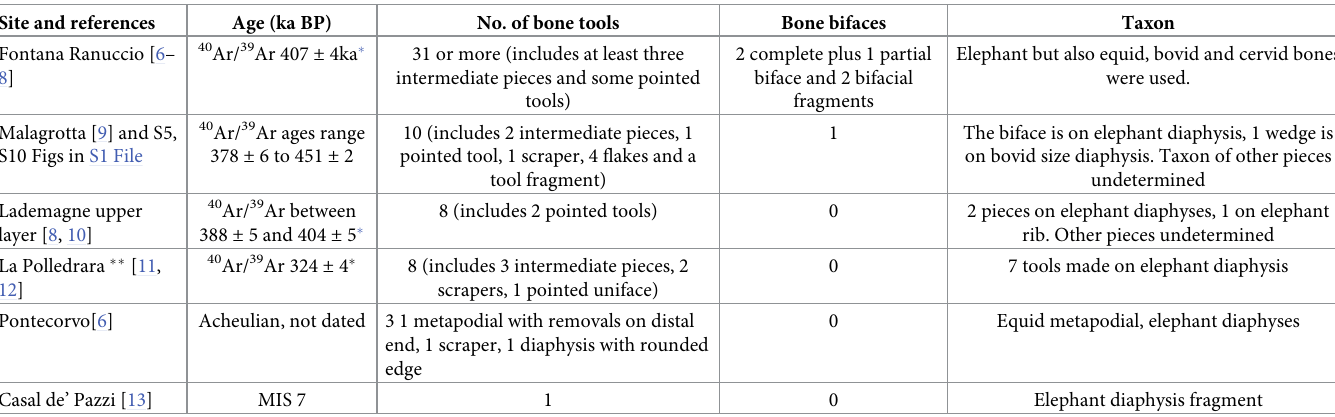
Table 1. Middle pleistocene latium sites with bone tools. Unretouched bone flakes are